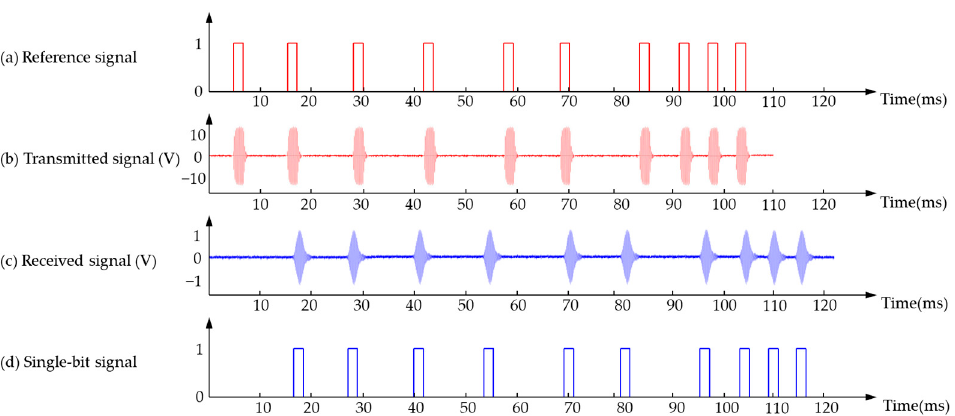
Figure 22. Signal processing procedure. ( a ) Reference signal; ( b ) Transmitted signal (V); ( c ) Received signal (V); ( d ) Single-bit signal.